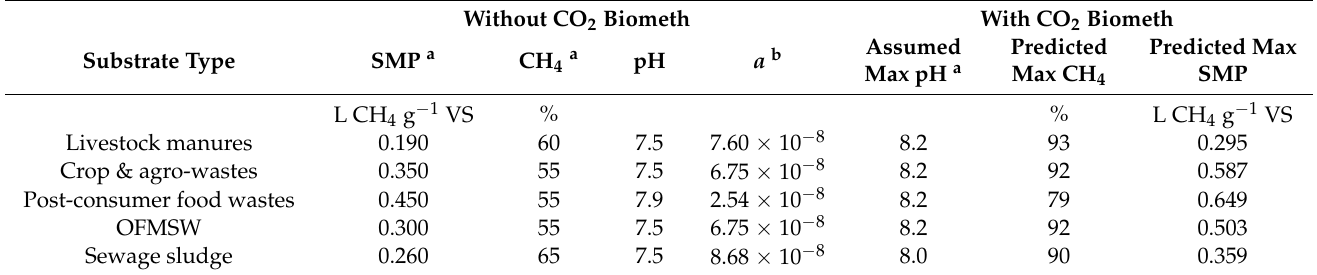
Table 1. Estimated maximum biogas methane content and SMP for use in